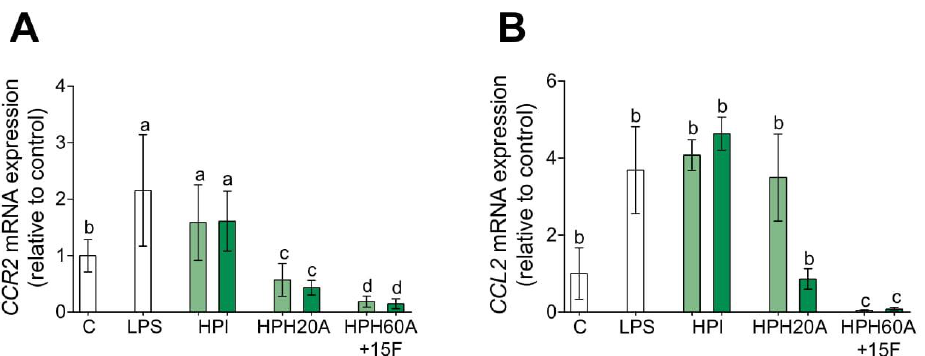
Figure 4. E ff ect of HPPs on chemotactic CCR2 / CCL2 gene expression in LPS-stimulated primary human monocytes. Monocytes were activated with LPS (100 ng / mL) and then treated with HPI, HPH20A, and HPH60A15F at 50 (light green bar) and 100 (dark green bar) µ g / mL for 24 h. Relative mRNA expression levels of CCR2 ( A ) and CCL2 ( B ) were detected by real-time quantitative PCR. Data are presented as means ± SD ( n = 3) and the significantly different ( p < 0.05) are labeled with contrasting letters.